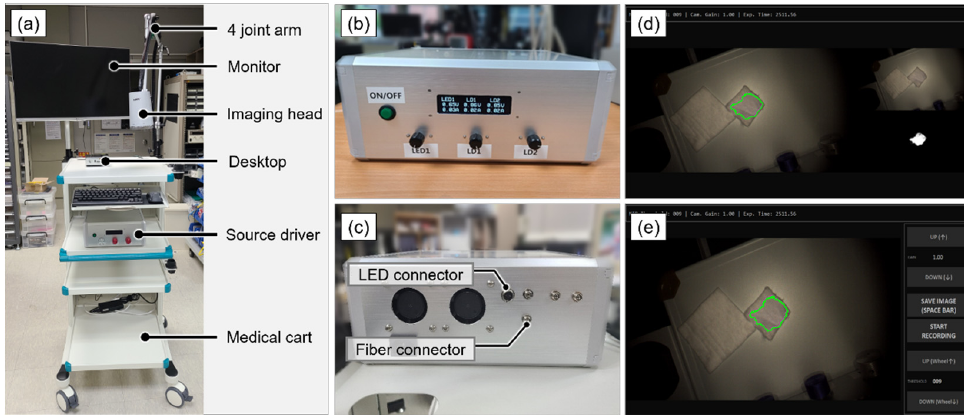
Figure 1. ( a ) NIR fluorescence imaging system. ( b ) Front panel of the source driver. ( c ) Rear panel of the driver. ( d , e ) Imaging acquisition program.